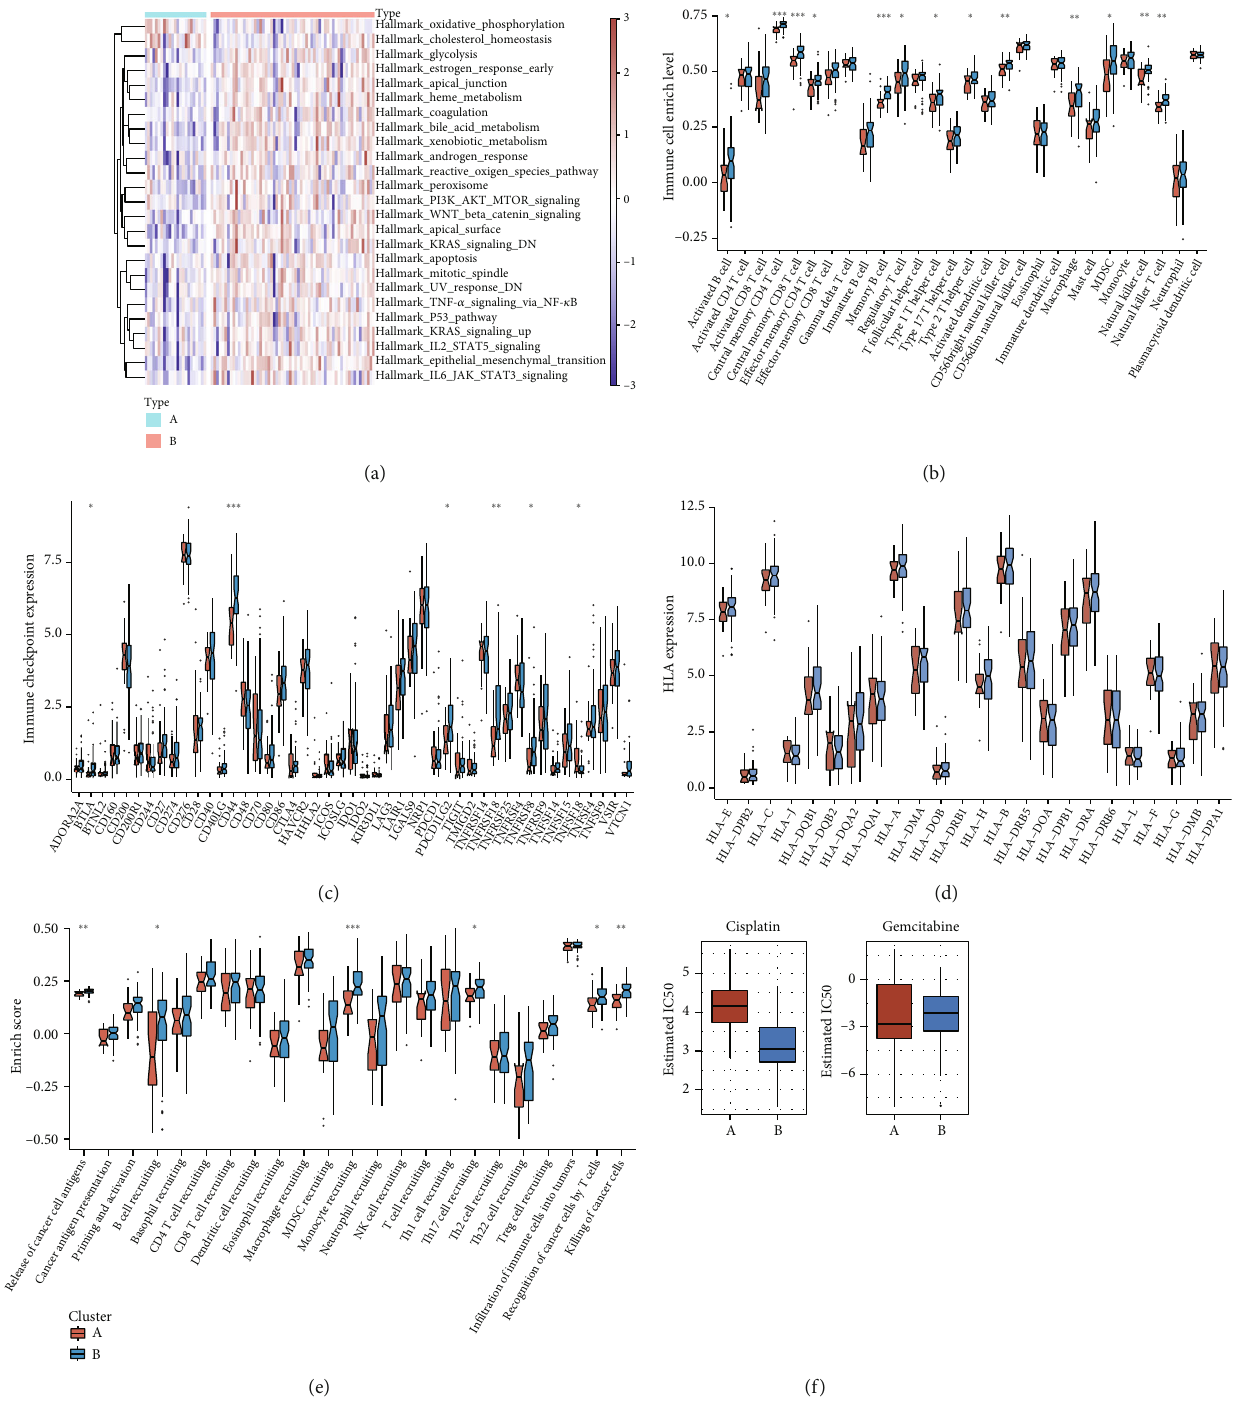
Figure 3: Immunological features and drug sensitivity of two EMT molecular subtypes. (a) Heat map depicts the activity of the 50 hallmark pathways in EMT subtypes A and B. (b) Boxplot shows the in fi ltrations of tumor-in fi ltrating immune populations in two subtypes. (c) Boxplot depicts the RNA expression of known immune checkpoint molecules in two subtypes. (d) Comparison of the RNA expression of HLA molecules in two subtypes. (e) Comparing the activities of all steps within cancer immunity cycle between subtypes. (f) Boxplot displays the sensitivity to cisplatin and gemcitabine in two subtypes. ∗ P value < 0 : 05 ; ∗∗ P value < 0 : 01 ; and ∗∗∗ P value < 0 : 001